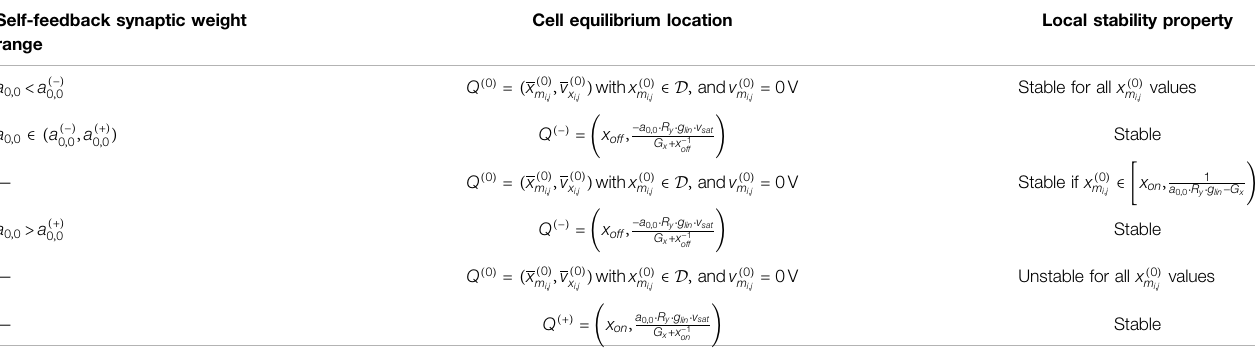
TABLE 2 | Location and local stability property of each of the equilibrium points, which a M-CNN cell may possibly admit, depending upon a 0 , 0 , under i w 2020b).Thecoordinatesof Q (−) , Q ( 0 ) ,and Q (+) areindicatedin Eqs.39 , 47 ,and 45 ,respectively.Withreference tothetablecontent,wede fi ne a (−) 0 , 0 b ~ x − 1 off · R − 1 y g − 1 lin ,and